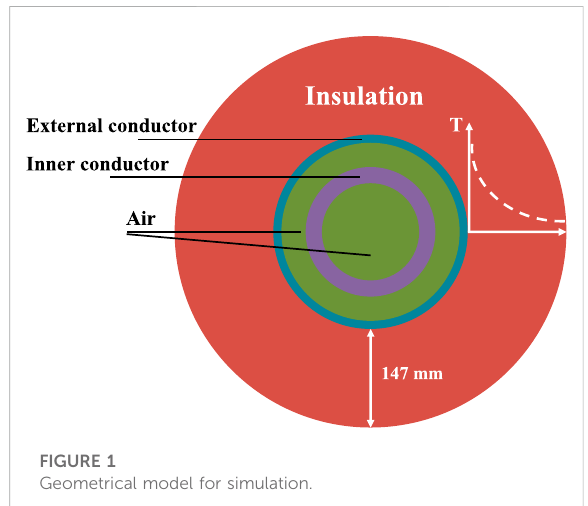
FIGURE 1 Geometrical model for